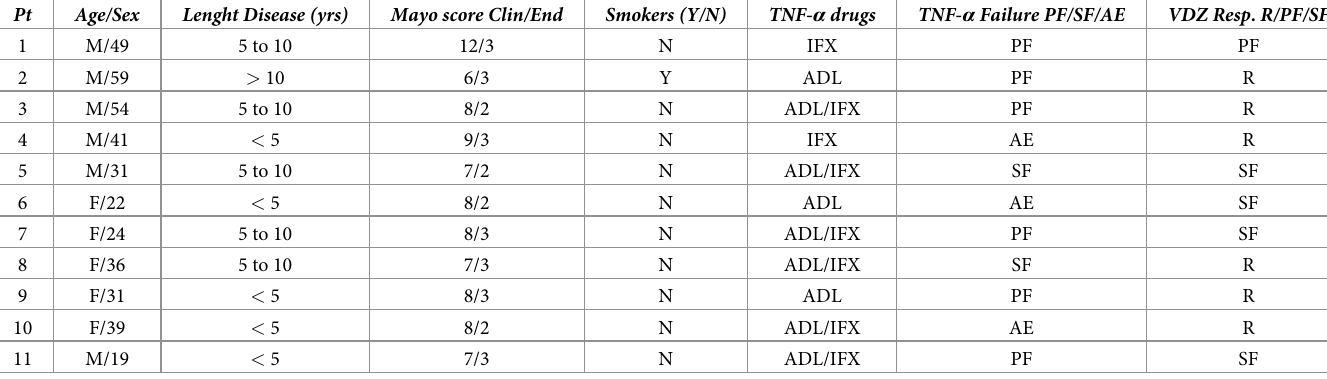
Table 1. Baseline characteristics of the IBD patients anti TNF- α